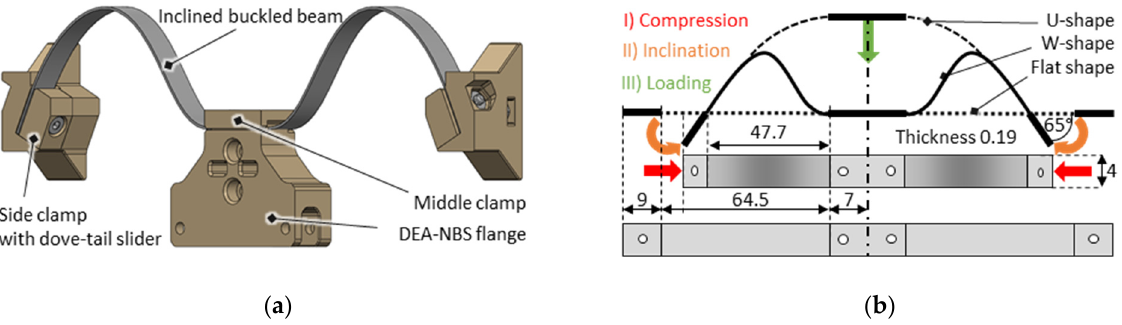
Figure 6. Inclined and centrally loaded buckled beam NBS shown as ( a ) CAD assembly and ( b ) schematic illustration with final geometrical construction parameters given (values with no unit in mm).